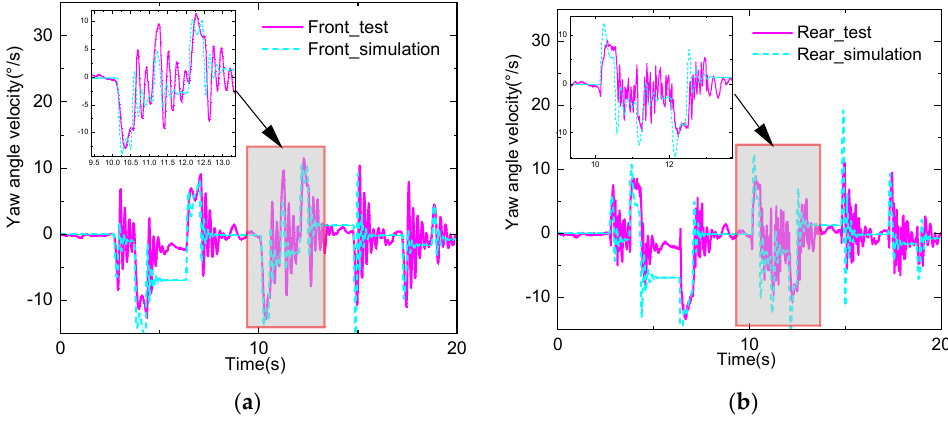
Figure 8. Lateral responses. ( a ) Front frame responses; ( b ) rear frame responses.